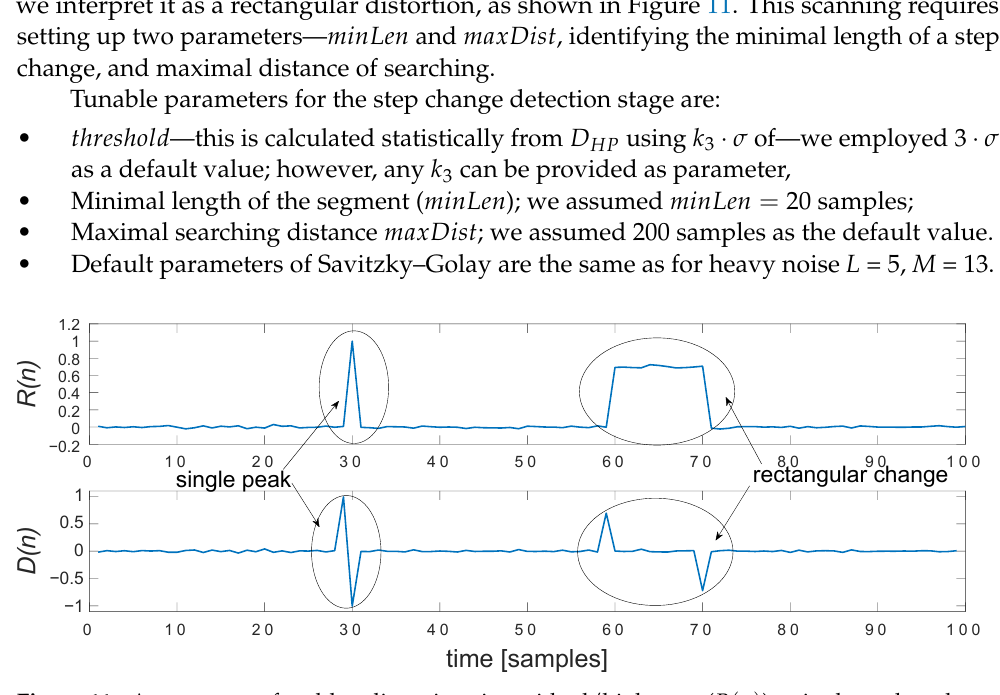
Figure 11. Appearance of sudden distortions in residual/high-pass ( R ( n ) )—single peak and step change, and their corresponding peak pairs in differential D ( n )